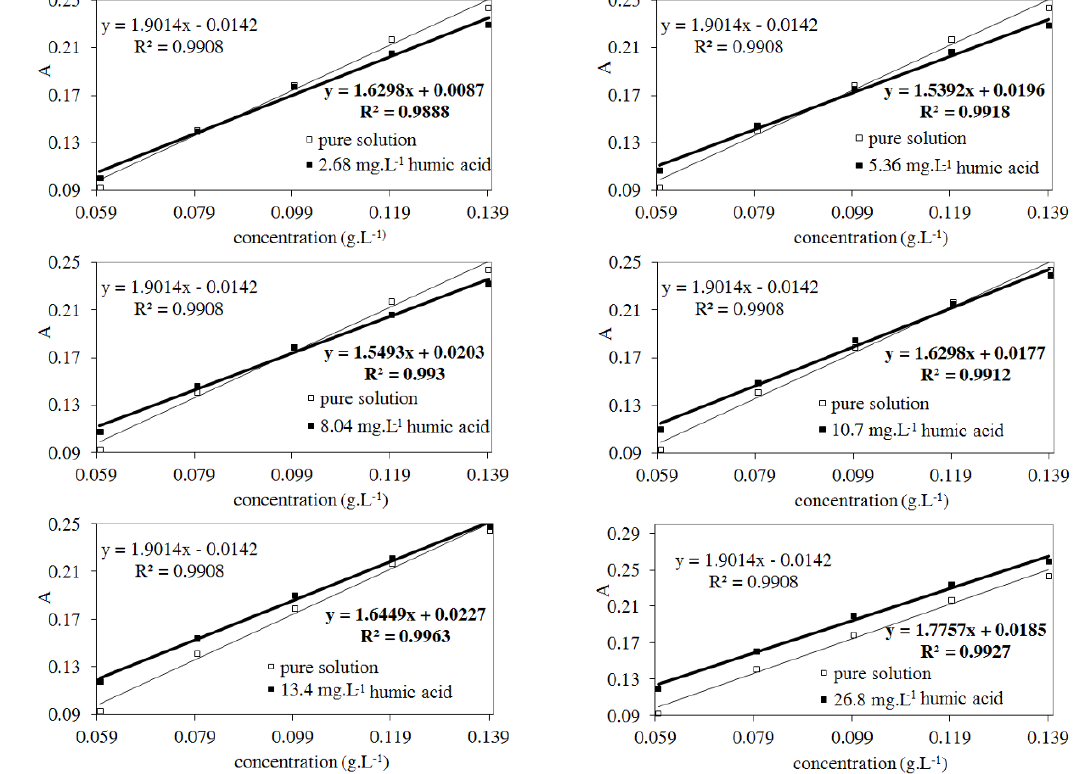
Figure 7. Calibration curves for Triton CF-21: comparison of curve measured in presence of particular humic acid concentration (where absorbances were lowered about absorbance of humic acid solution with the same concentration, see Table 1) with the calibration curve achieved in the system containing no humic acid.